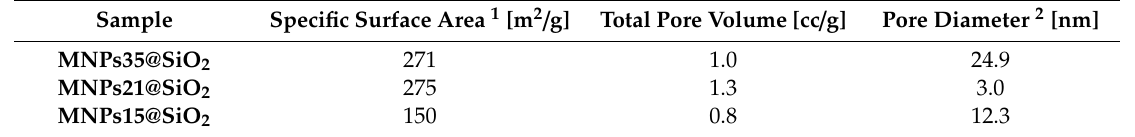
Table 5. Specific surface area, total pore volume and pore diameter of the samples.